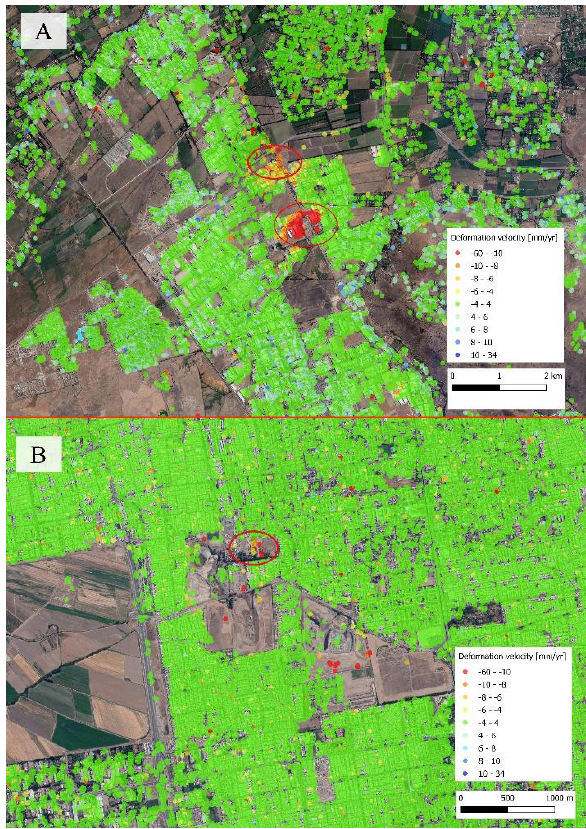
Figure 3. (up) Deformation velocity map of Santiago (bottom) Deformation velocity map of